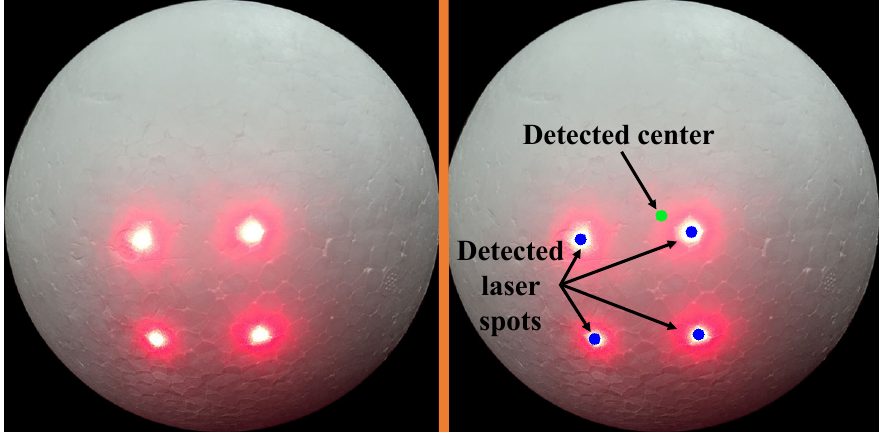
Figure 9. The image of the target sphere ( left ) and detected laser spots and the center point ( right ).